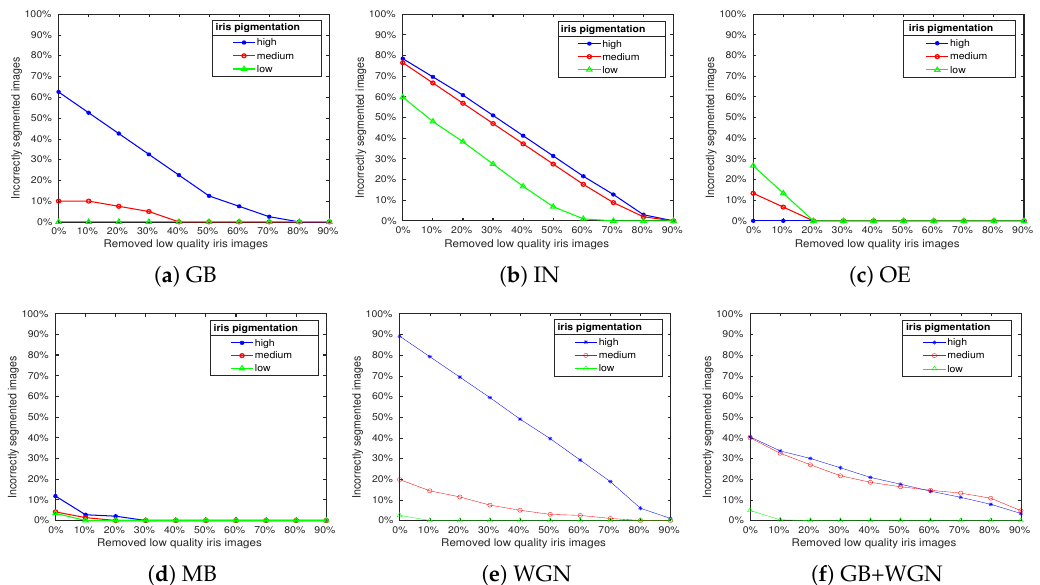
Figure 3. The segmentation performance of the reference iris recognition system is shown for segmenting iris images with high, medium, and low pigmentation, and distorted in different ways. The fraction of incorrectly segmented images is plotted versus the percentage of filtered low-quality images, based on the differential sign–magnitude statistics index (DSMI)